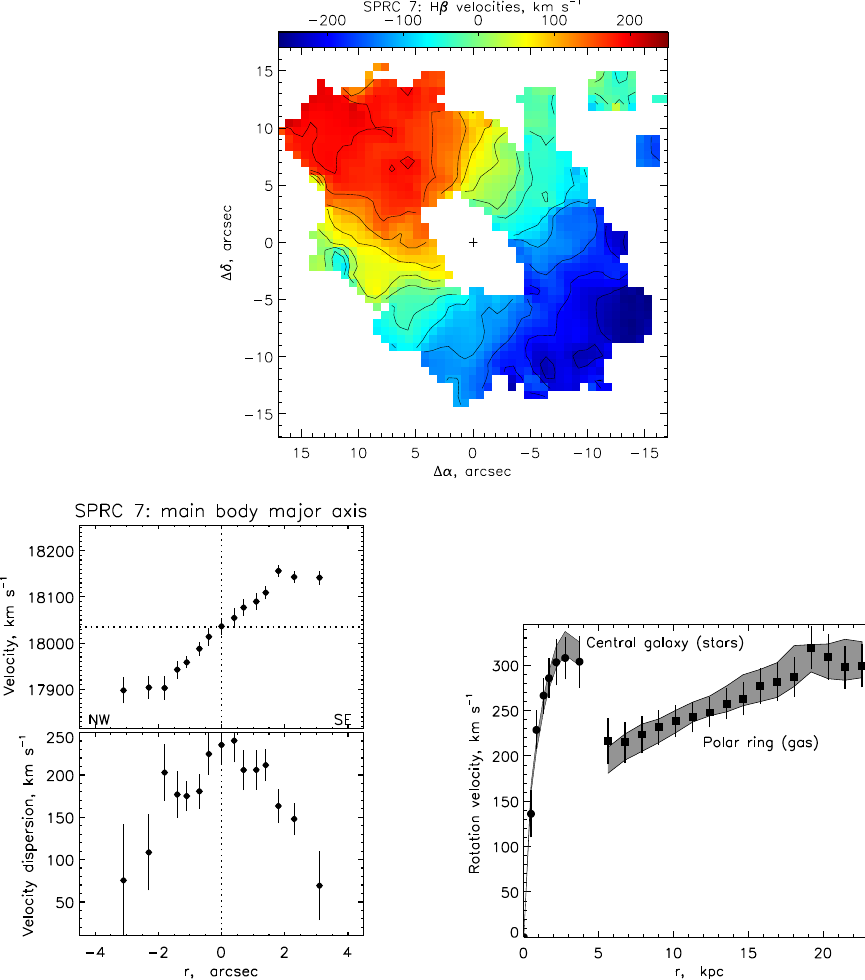
Fig. 2. Kinematics of the SPRC-7 galaxy studied with the 6 m telescope (Special Astrophysical Observatory, Russian Academy of Sciences): the ionized gas velocity (cid:12)eld of the polar disk (top panel); the line-of-sight velocity and velocity dispersion distribu- tions for stars along the host galaxy’s major axis, obtained from long-slit spectroscopic observations (bottom, left); the (cid:12)t of the rotation curves of both components with the model including a NFW halo with c=a = 1 : 5 (bottom,